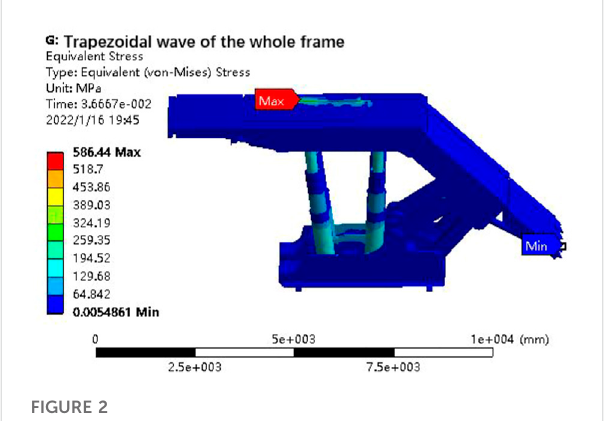
FIGURE 2 Stress nephogram of the whole